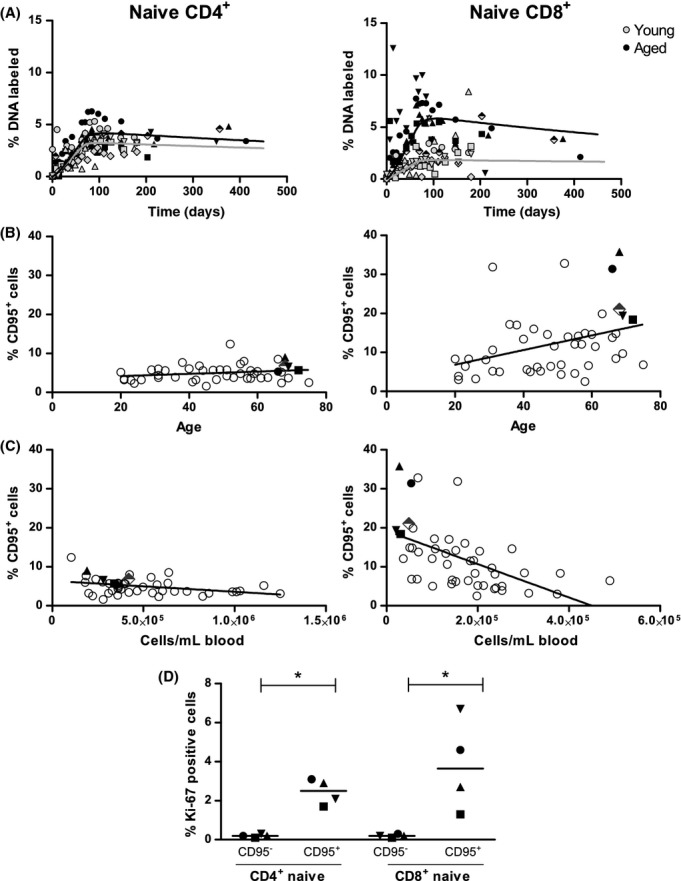
Analysis of 2H enrichment and CD95 expression within the naive T-cell pools. (A) Best fits of the mixed effect multi-exponential model (see Data S1; Supporting information) to 2H enrichment in the DNA of naive CD4+ and CD8+ T cells from young [(Vrisekoop et al., 2008), gray symbols and curve] and elderly individuals (black symbols and curve). Label enrichment was scaled between 0 and 100% by normalizing for the maximum enrichment in granulocytes. (B, C) The expression of CD95 on naive CD4+ (left) and CD8+ (right) T cells was determined in elderly males (black symbols) of the 2H2O labeling study and in other healthy donors of varying ages (open symbols, n = 41). The percentage of CD95+ naive T cells was plotted against age (B) and against the number of naive CD4+ or CD8+ T cells per ml blood (C). The elderly male who tested seropositive for CMV is depicted by a semi-filled diamond (B+C). The lines in panels (C) and (D) represent linear regression analyses. (D) Ki-67 expression was measured within the CD95− and CD95+ fractions of naive CD4+ and CD8+ T cells in elderly males of our labeling study (n = 4). The median is represented by a horizontal line. Different symbols indicate different individuals. Asterisks mark significant differences (P-value < 0.05).